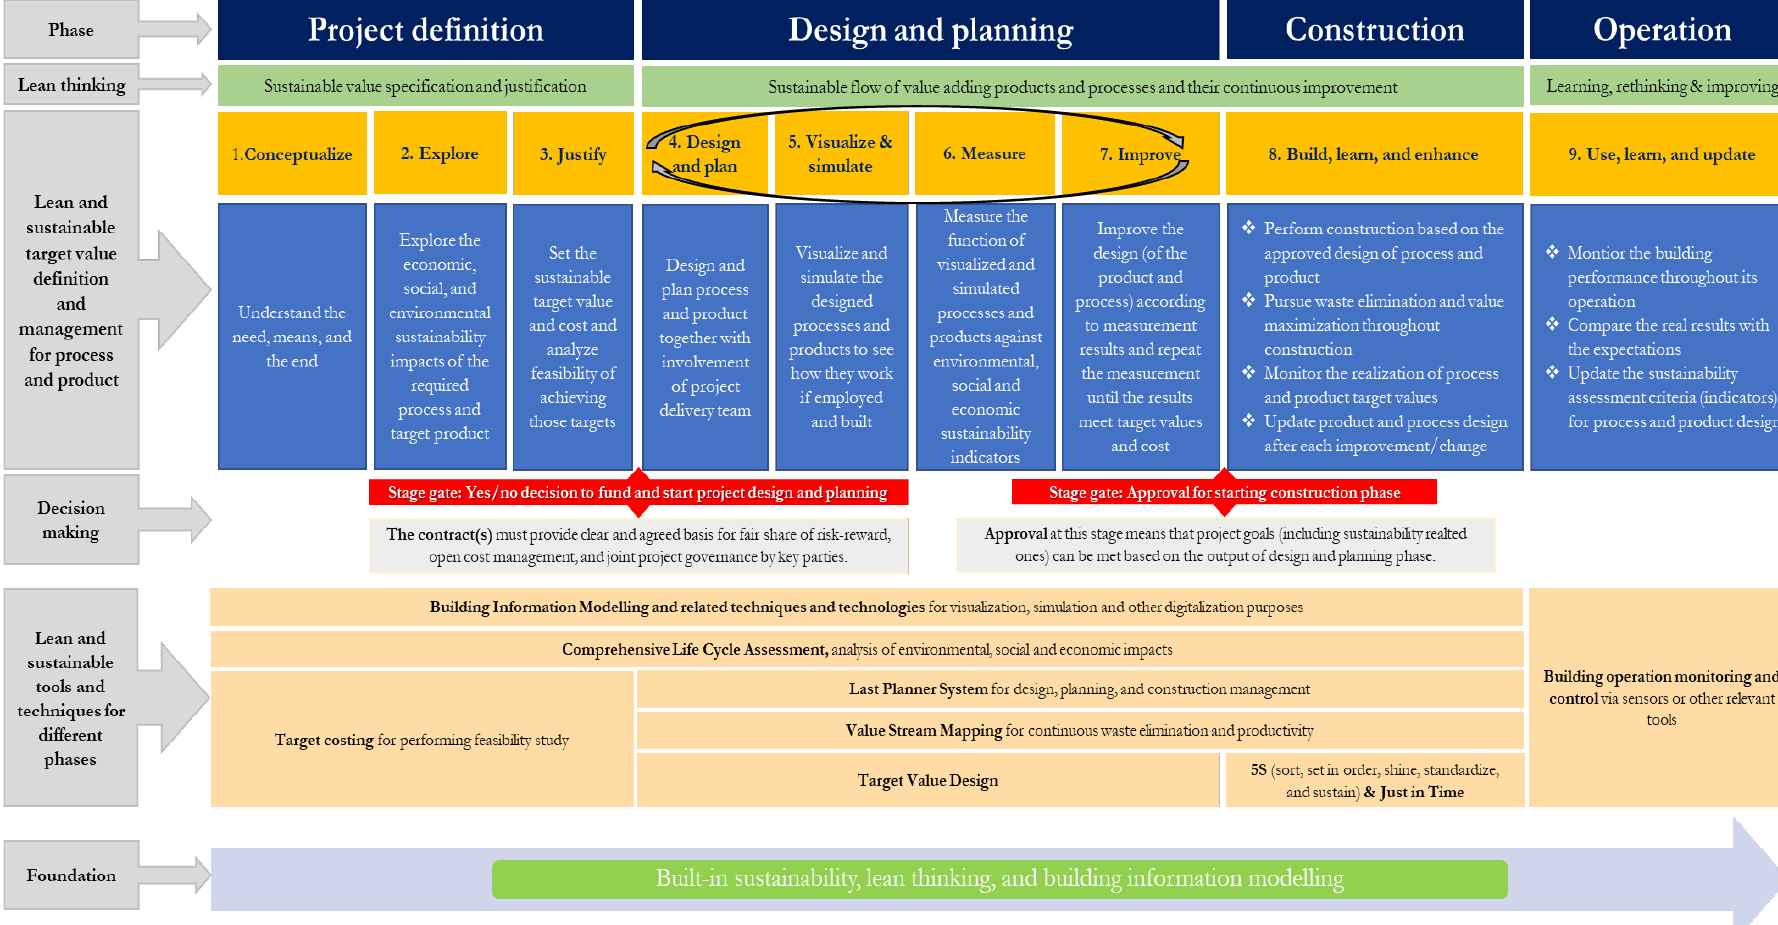
Figure 3. Conceptual framework for lean and sustainable delivery of building construction projects.